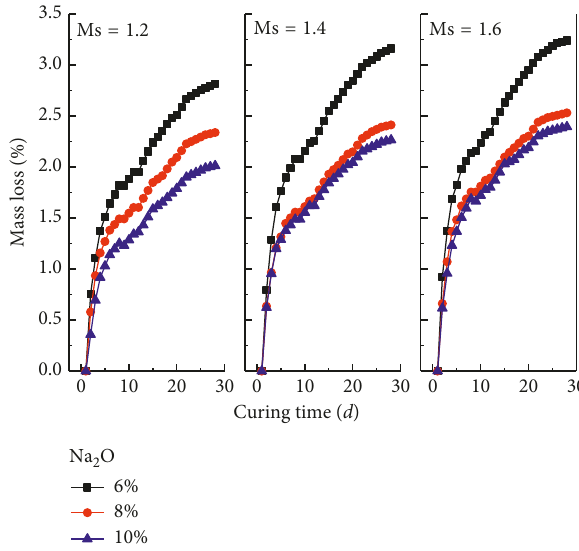
Figure 7: The effects of silicate moduli and Na compressive strength of AAS